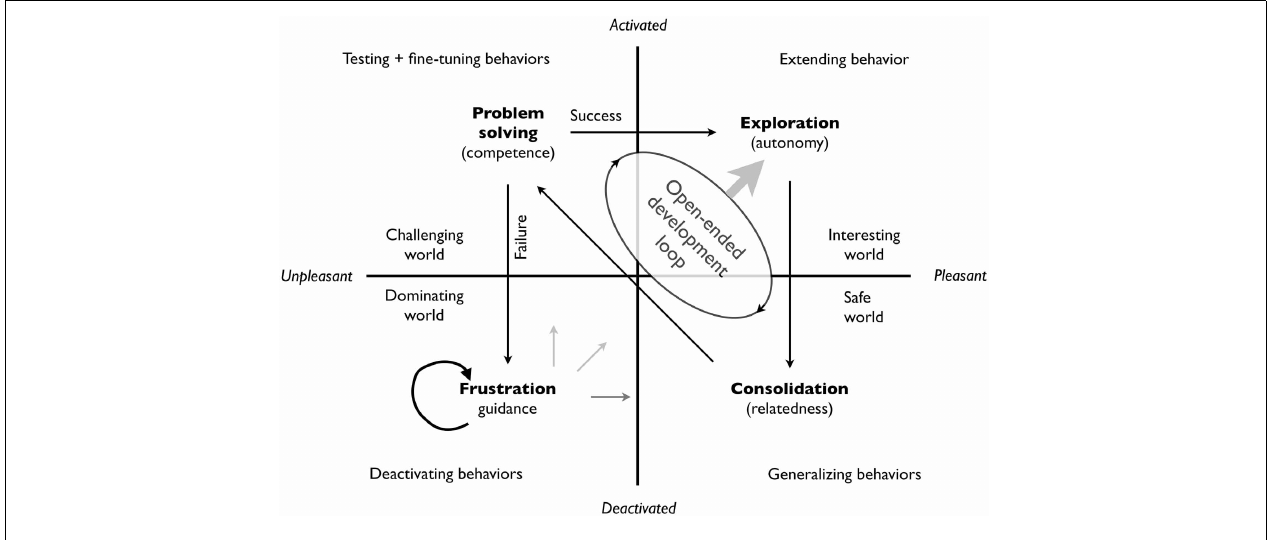
FIGURE 5 | Open-ended development loop. The words in brackets originate from Ryan and Deci (2000). The loop depends essentially on the rewards signals associated with exploration (experiencing novelty), consolidation